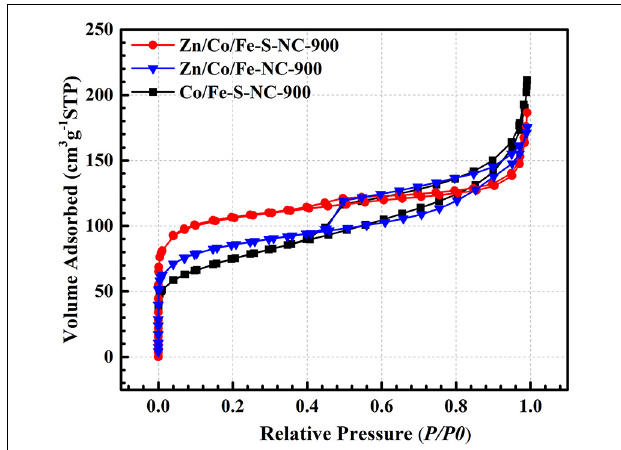
FIGURE 6 | N 2 adsorption/desorption isotherms of Zn/Co/Fe–S–NC-900, Zn/Co/Fe–NC-900, and Co/Fe–S–NC-900.